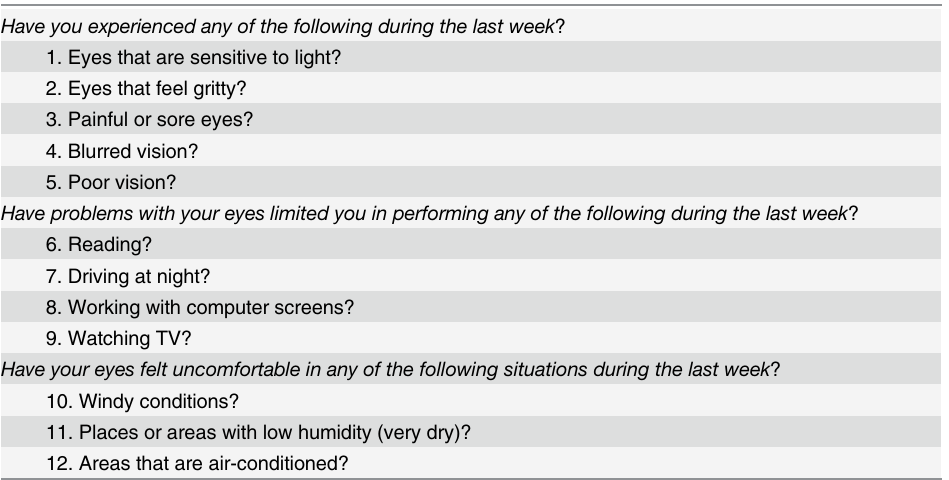
Table 2. Ocular Surface Disease